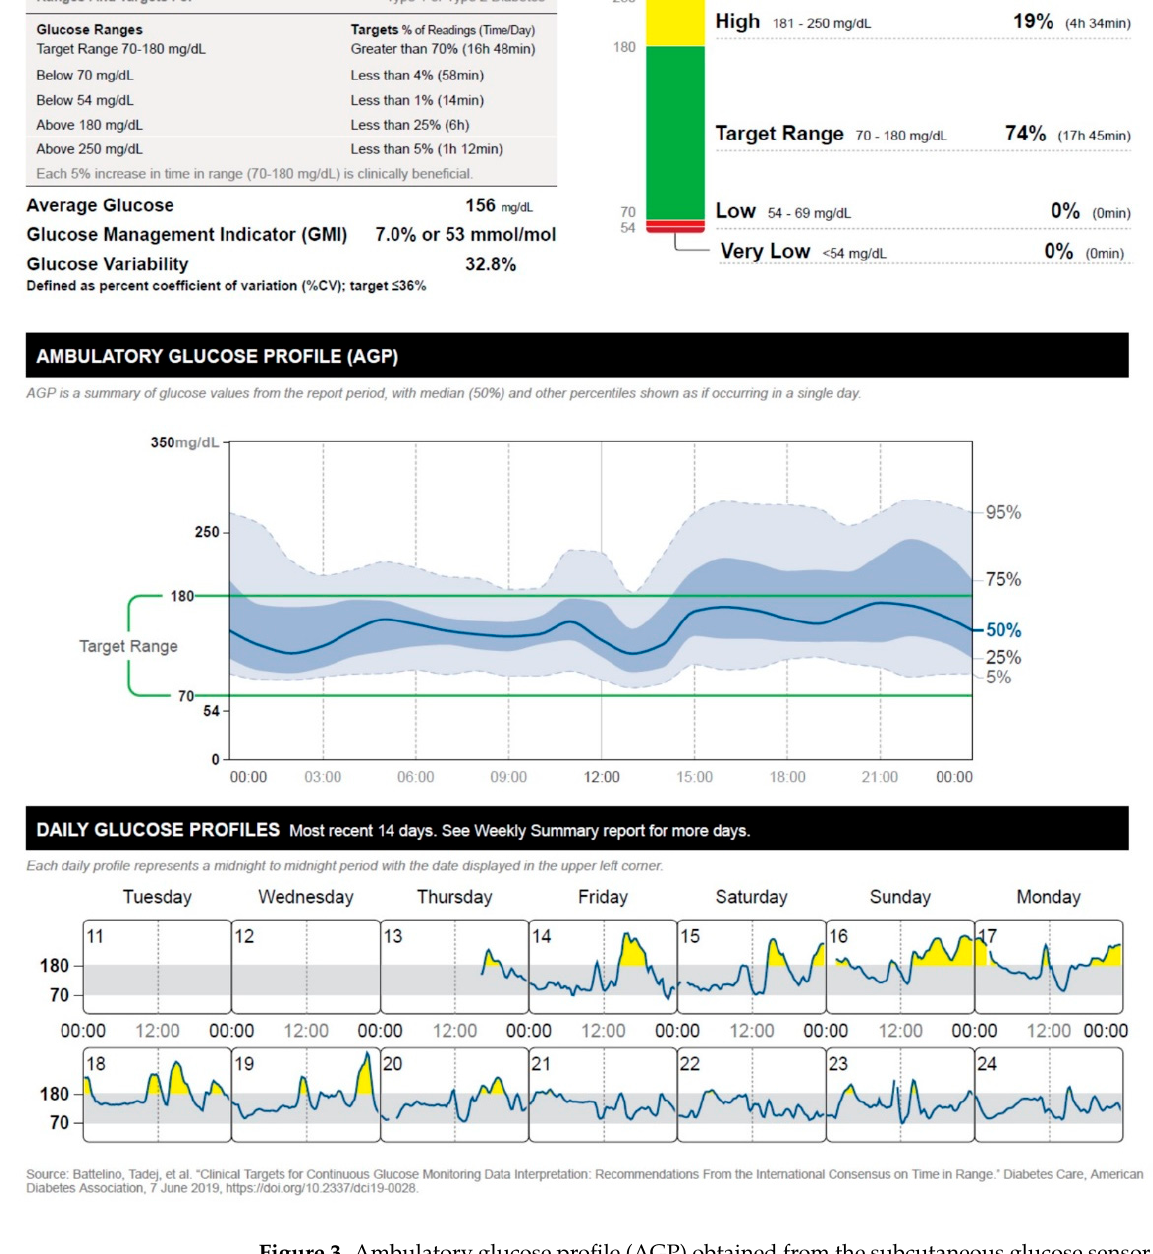
Figure 3. Ambulatory glucose profile (AGP) obtained from the subcutaneous glucose sensor referring to the 21 days after the second vaccine dose injection (4 January 2022 through 24 January 2022).